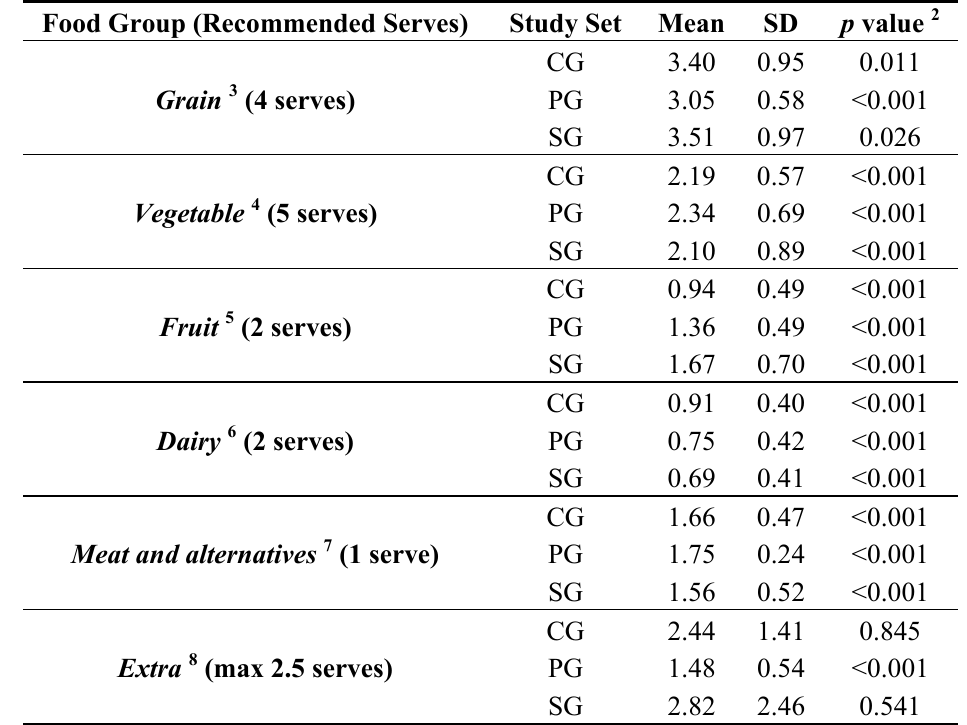
Table 3. Mean number of serves 1 consumed by the control (CG), pork diet (PG) and supplement (SG)